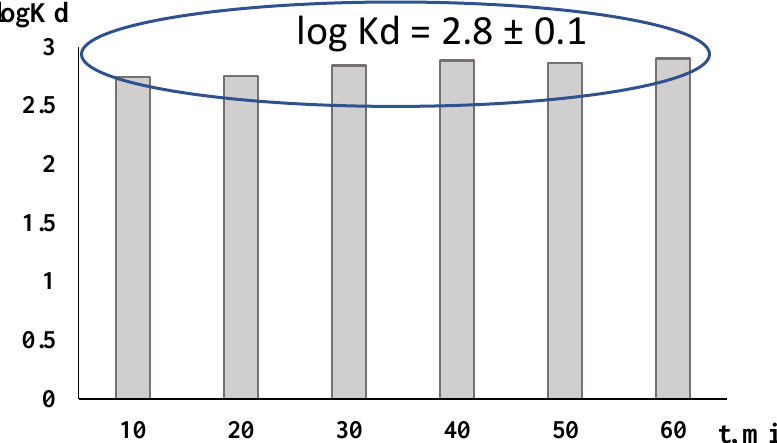
Figure 3. Distribution coefficient Ag(I) as a function of phase contact time at 298 K (equilibrium nitric acid concentration 0.1 М).